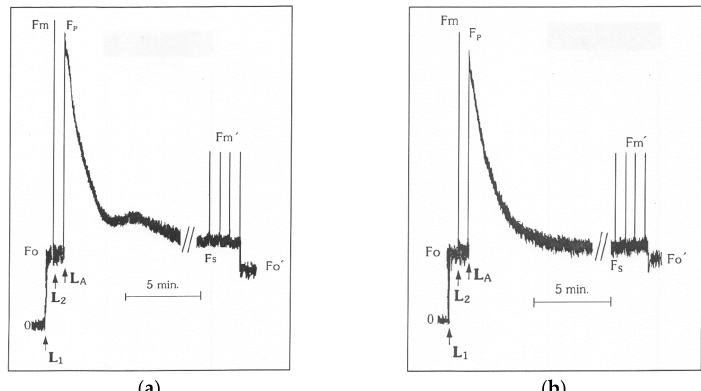
Figure 1. Typical modulated fluorescence signals obtained by the triticale (X Triticosecale Witmark cv. ‘Dada’) after 20 min dark adaptation; ( a ) control leaves from plants in the nutrient solution at pH 6.5; and ( b ) leaves from plants in the nutrient solution plus 148 µ M Al at pH 4.5; L 1 , arrow denotes onset of a weak modulated light beam; L 2 , arrow denotes onset of a saturating light pulse (approximately 8000 µ mol photons m − 2 s − 1 ); L A , arrow denotes continuous actinic